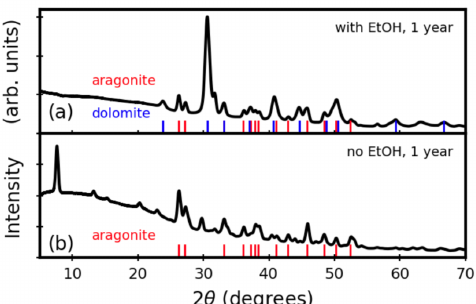
Figure 2. Representative PXRD data for samples after 1 year of aging: ( a ) with EtOH; and ( b ) without EtOH. The red lines correspond to peaks that were indexed to aragonite; the blue lines correspond to peaks indexed to